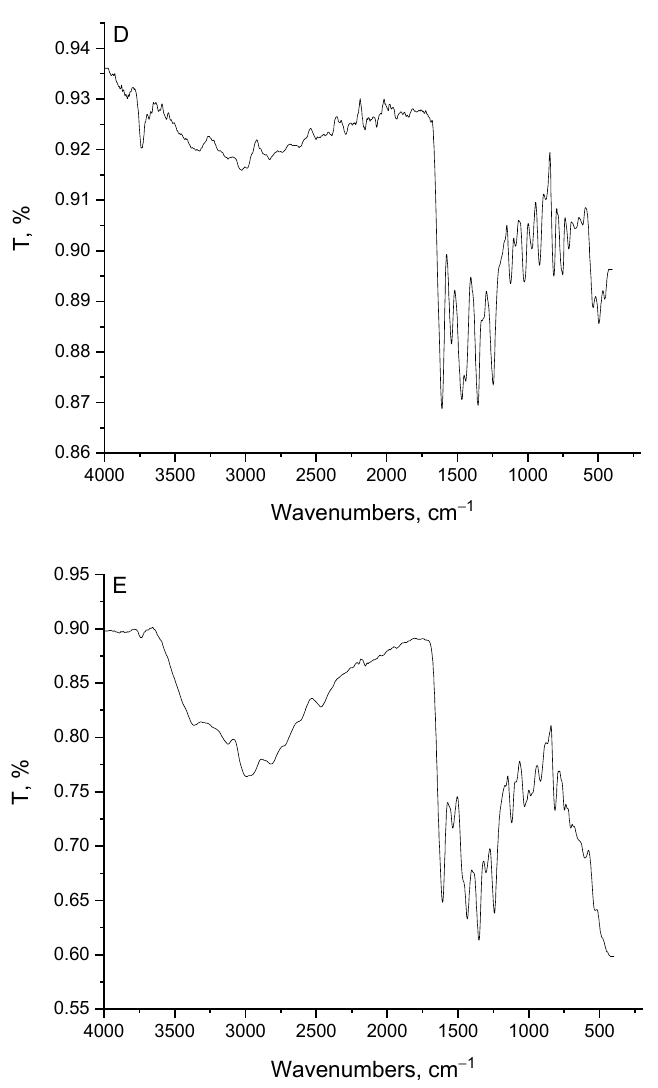
Figure 3. Infrared spectra of ( A ): pipH free ligand and its complexes ( B ): Mg(II), ( C ): Ca(II), ( D ): Zn(II), and ( E ): Fe(III). ( D ): Zn(II), and ( E ):